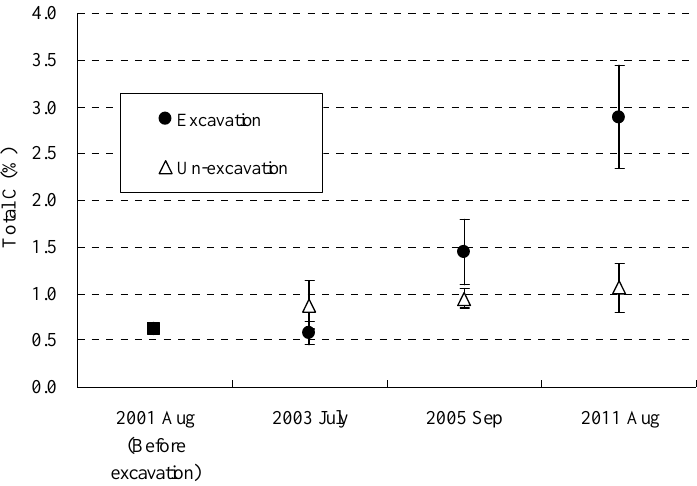
Figure 10. Soil organic carbon content (tC/ha) in 5 cm soil depths at three different times as indicated. Bars denote the means and standard deviations of 9–10 replicates. Data with different letters are significantly different (Tukey’s HSD test, p <